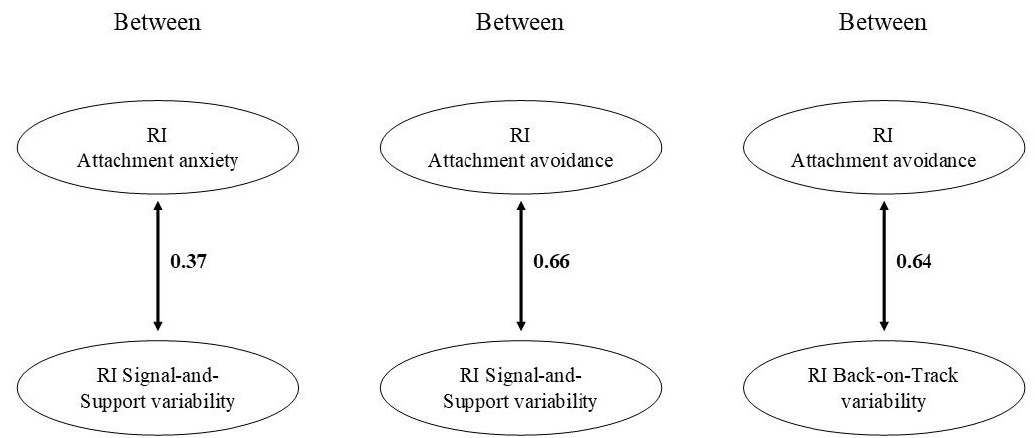
Figure 3. Significant associations from the RI-CLPMs with trait Attachment anxiety and Attachment avoidance. Standardized estimates are presented. RI = Random intercept.